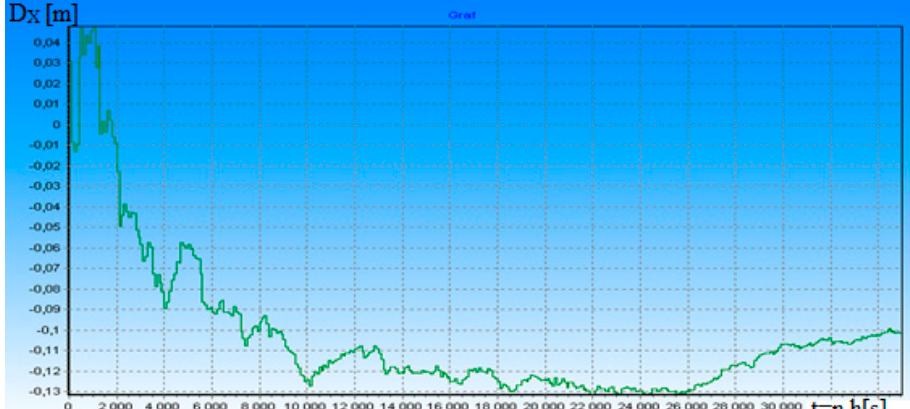
ρ = 2. Int. J. Environ. Res. Public Health 2019 , 16 , x FOR PEER REVIEW